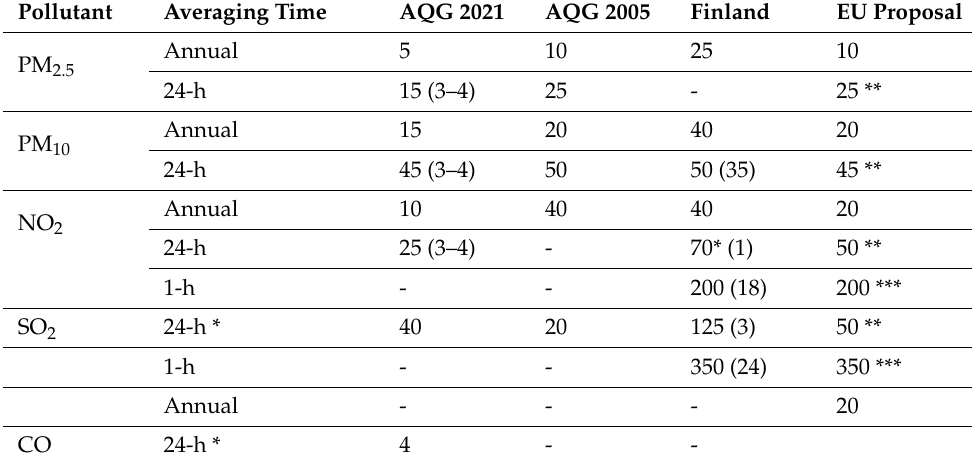
Table 1. WHO 2021 revised guideline levels (AQC 2021), previous guideline levels (AQC 2005) and the Finnish threshold values for air pollutant concentrations in µ g/m 3 . Number of allowed exceedances per year in parenthesis. * Guidance level, one exceedance permitted, ** not to be exceeded more than 18 times per year and *** not to be exceeded more than once per